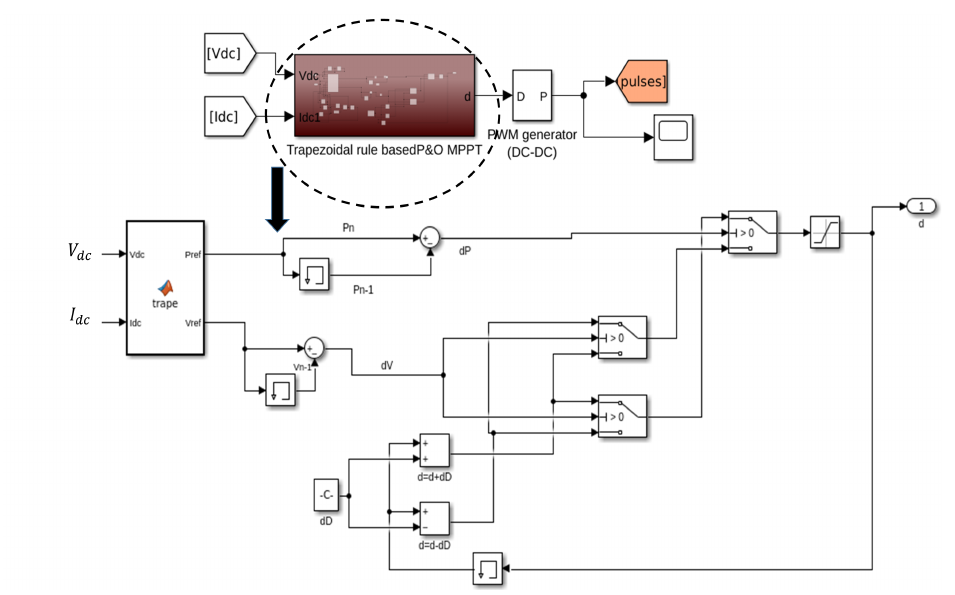
Figure 13. SIMULINK block for the proposed